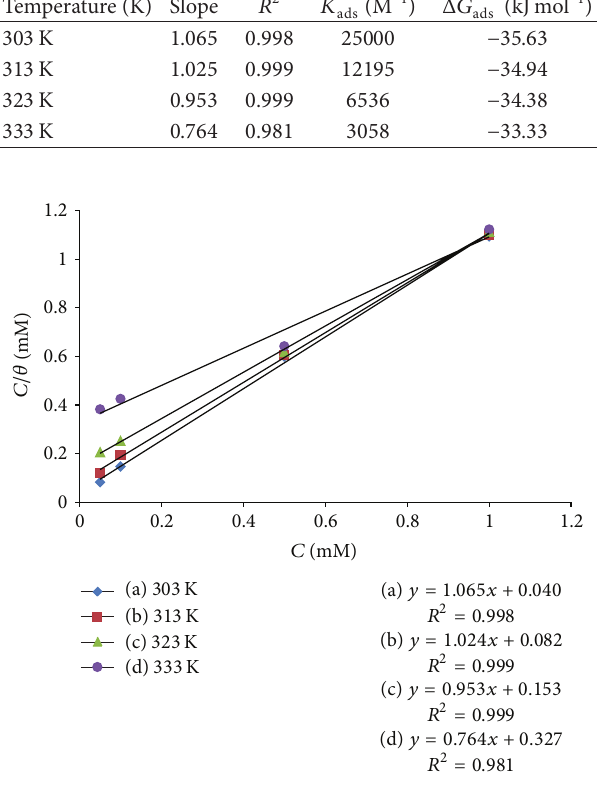
Figure 2: Langmuir adsorption isotherm for adsorption of RS on the mild steel surface in 1M HCl.